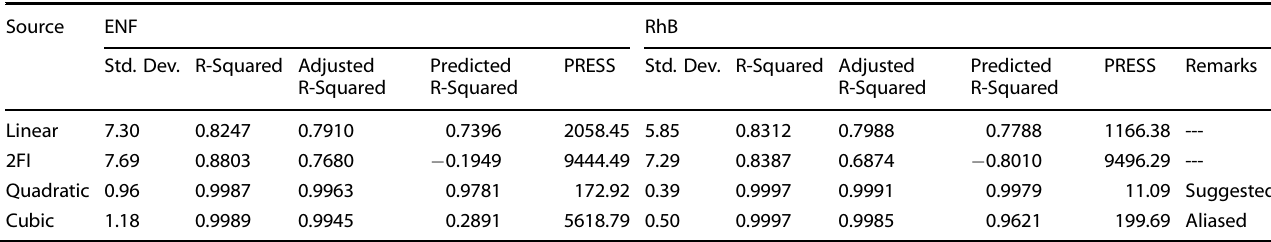
Table 1. Statistical parameters for different models.